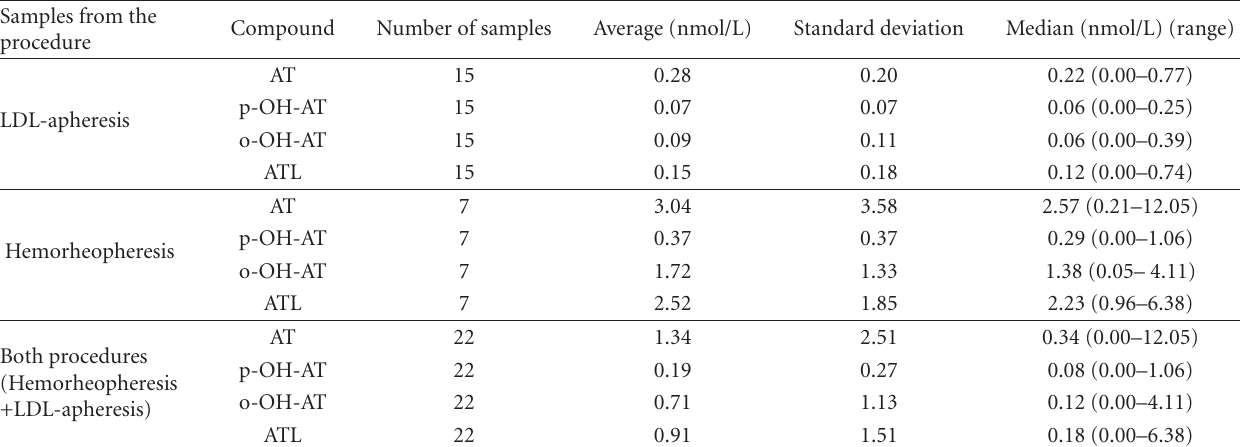
Table 2: Atorvastatin and its metabolites in waste fluids.